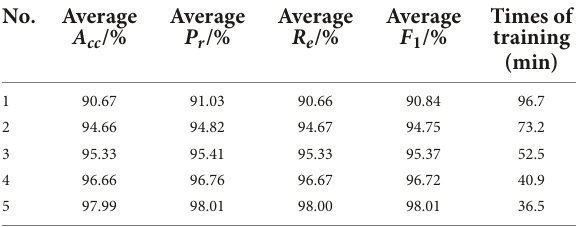
TABLE 2 Results of ablation experiment.